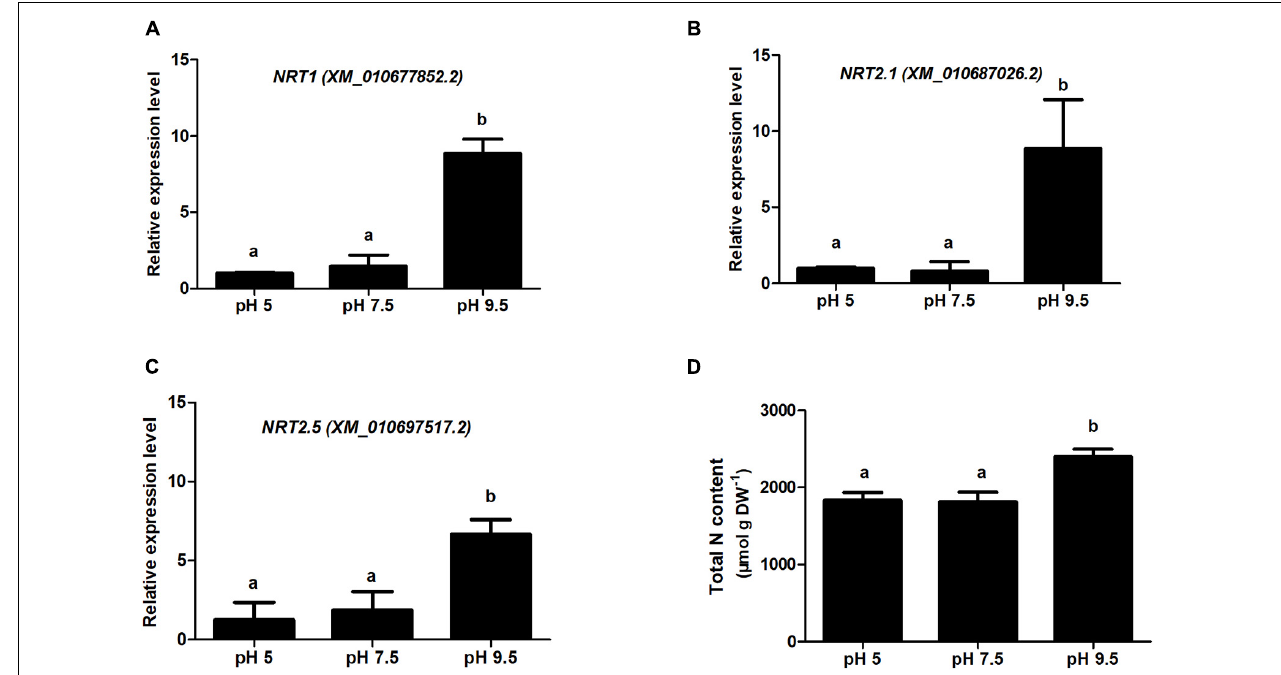
FIGURE 7 | Relative gene expression for nitrate transporter (NRT) examined using QRT-PCR and analysis of total nitrogen content in sugar beet under different pH conditions. (A-C) indicate the QRT-PCR results of NRT1 , NRT2.1 , and NRT2.5 in the root samples treated with different soil pH. (D) indicates the total nitrogen content of sugar beet seedlings under different pH conditions. Different letters indicate significantly different at p <